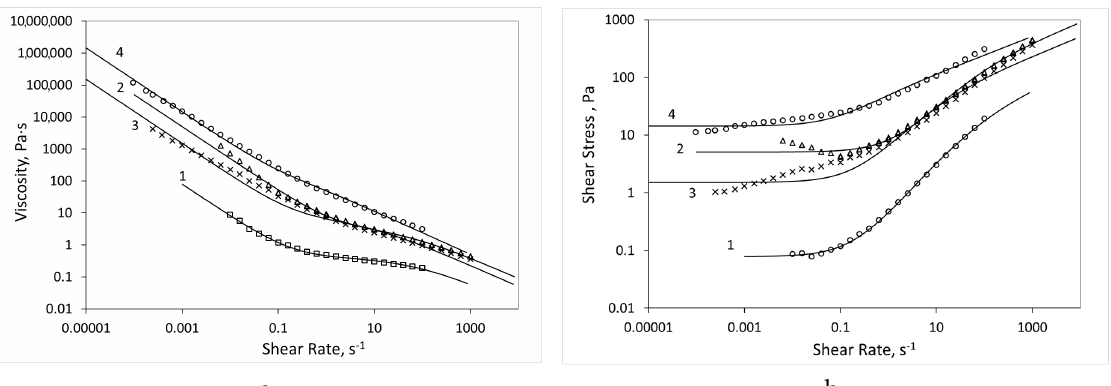
Figure 4. Dependence of viscosity ( a ) and shear stress ( b ) on the shear rate in the shear test (Down SR mode). Dots represent experimental values, lines were fitted using the Cross